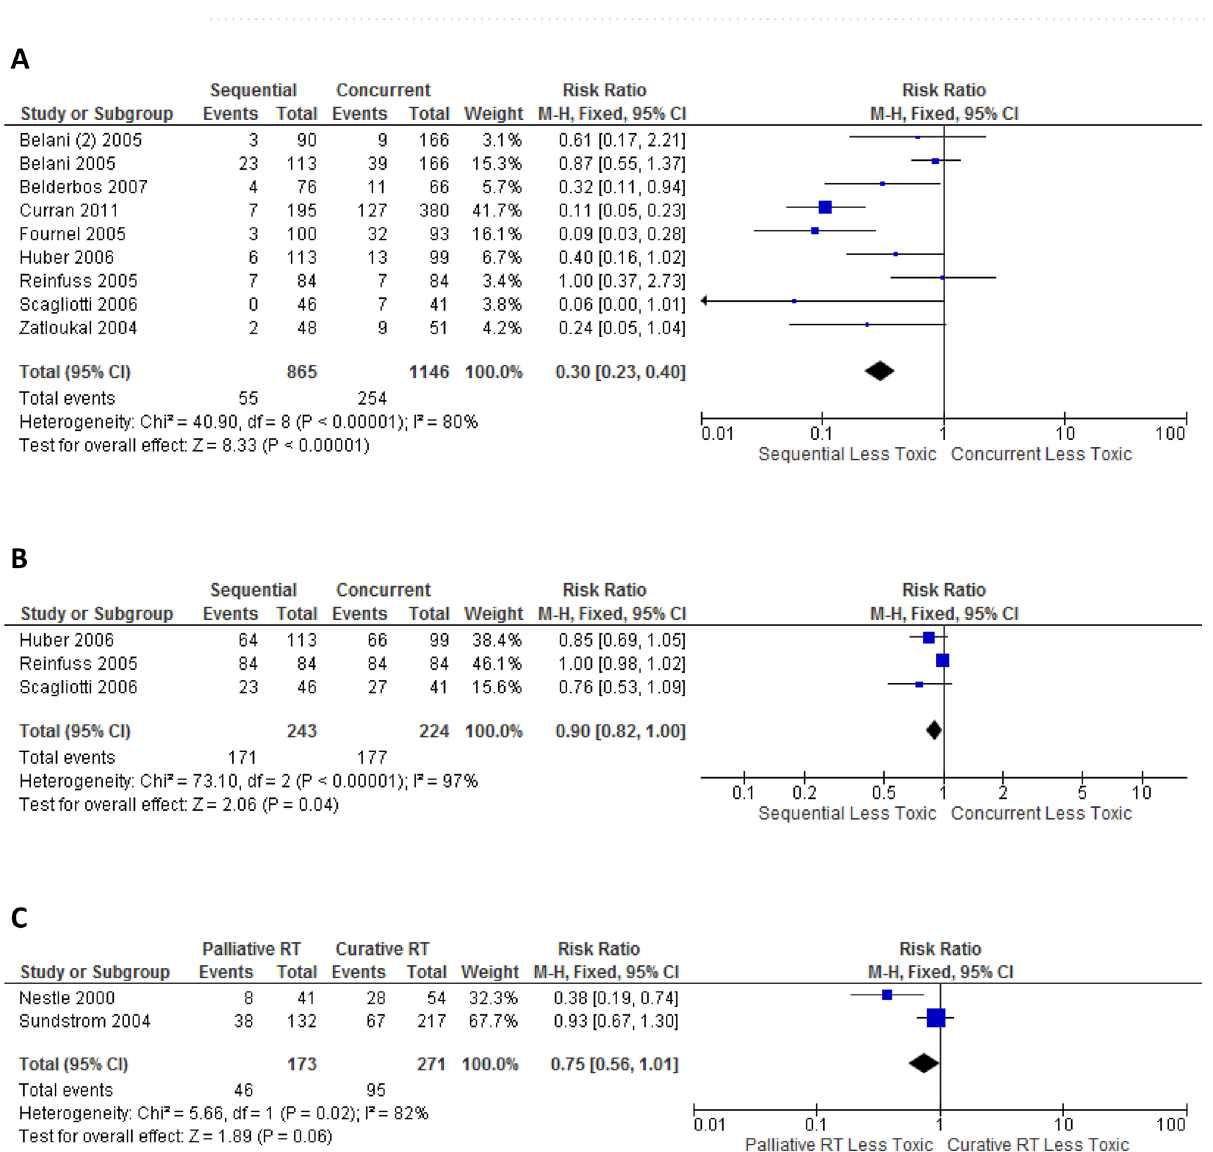
Figure 2. Forest plot showing toxicity risk ratio (RR) for treatment-related death; comparison between sequential versus concurrent chemoradiation, generated with Cochrane Review Manager version 5.3